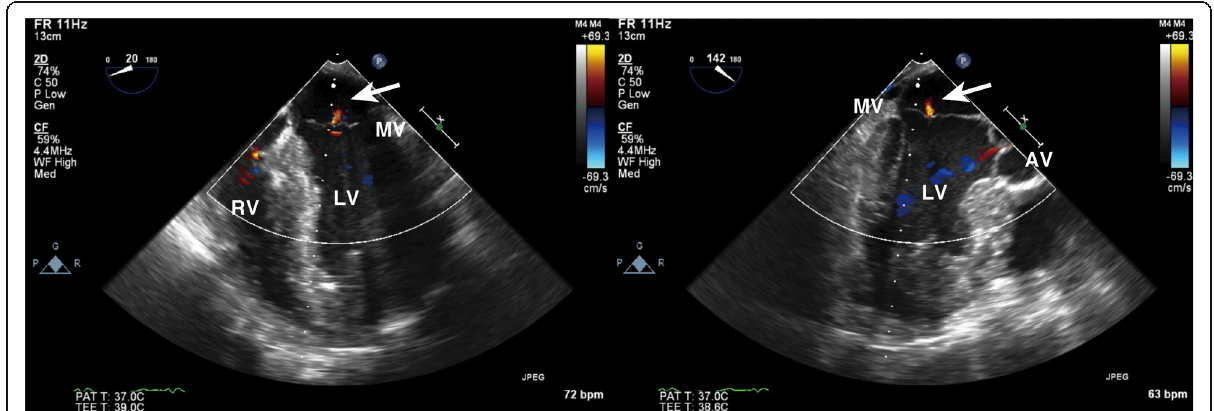
Fig. 4 Color-flow Doppler images of mid-esophageal four chamber view (left) and midesophageal long axis view (right) after weaning from cardiopulmonary bypass. There is trivial mitral regurgitation (arrow) after the repair. AV aortic valve, LV left ventricle, MV mitral valve, RV right ventricle